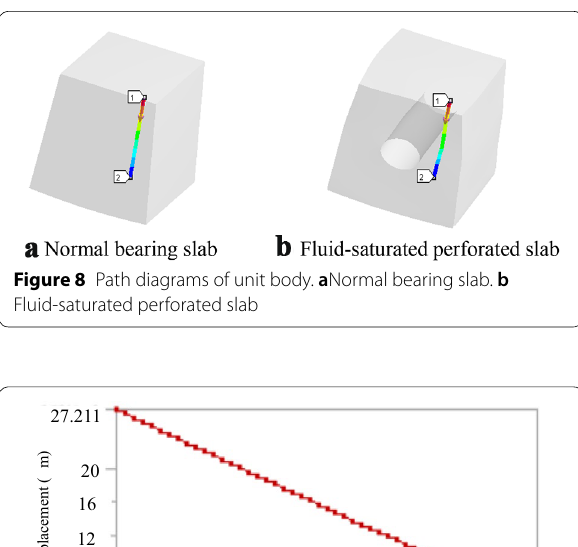
a Unit body of normal bearing slab